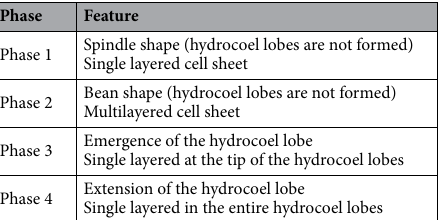
Table 1. Features of hydrocoel tissue in each phase of the hydrocoel-lobe morphogenesis.